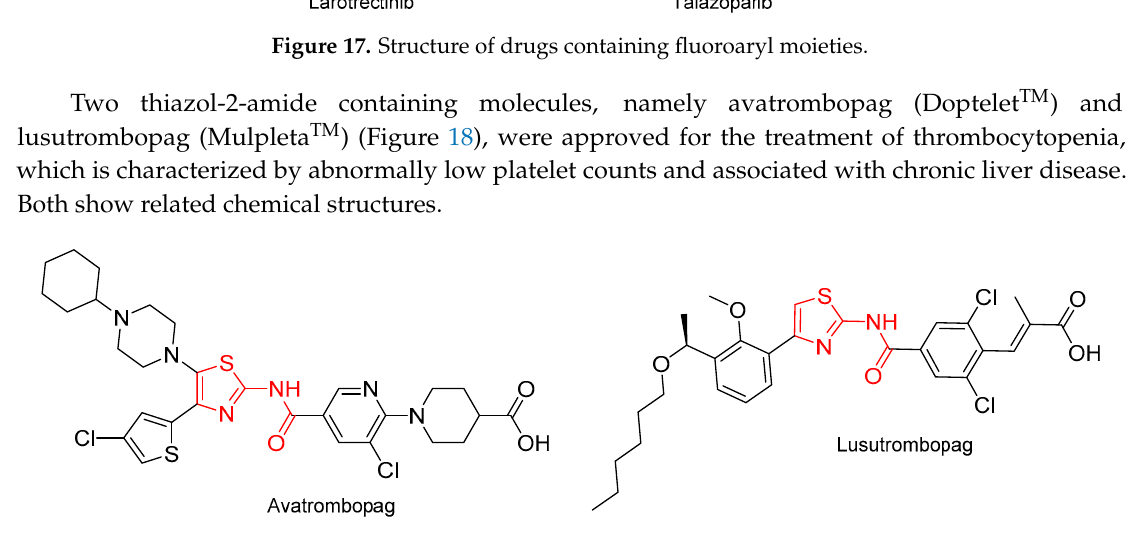
Figure 19. Structure of drugs for the treatment of acute myeloid leukemia. The following drugs with nitrogen-based aromatic heterocycles were also approved last year: baricitinib (Olumiant ™ ) for rheumatoid arthritis; duvelisib (Copiktra ™ ) for various hematologic malignancies such as chronic lymphocytic, small lymphocytic, and follicular lymphomas; and amifampridine (Firdapse ™ ), which just is 3,4-diaminopyridine, for Lambert–Eaton myasthenic syndrome, which is a muscle disease (Figure 20). In 2010, the FDA also approved 4-diaminopyridine Ampyra ™ to improve walking in adults with multiple sclerosis. Figure 20. Structure of baricitinib, duvelisib, and amifampridine. Four more small-molecule drugs were approved in 2018, namely stiripentol (Diacomit ™ ) for Dravet syndrome, which is an intractable infancy epilepsy, lofexidine (Lucemyra ™ ) for the management of the physical symptoms of opioid withdrawal, prucalopride (Motegrity ™ ) for chronic idiopathic constipation, and revefenacin (Yupelri ™ ) for chronic obstructive pulmonary disease (COPD). Lofexidine is a racemic mixture (Figure 21).